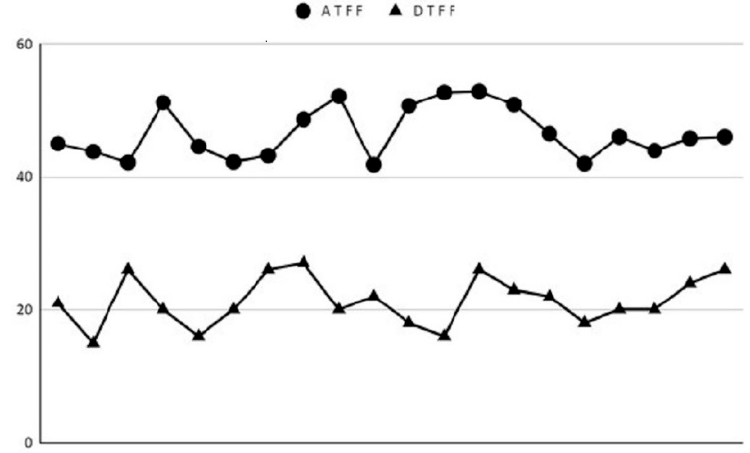
Figure 12. Driver responses across the board for a close-by construction hazard for the morning scenario in terms of time to first fixation and distance from a hazard at first fixation.